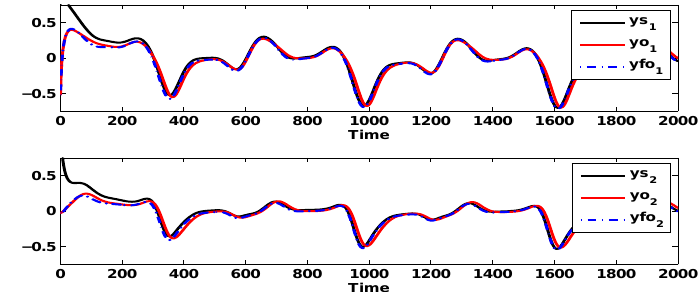
Figure 1. Outputs of the fractional-order Takagi–Sugeno (FOTS) system and its estimation by FOUIO and fractional order unknown input observer (FOUIO) in a free of fault case.